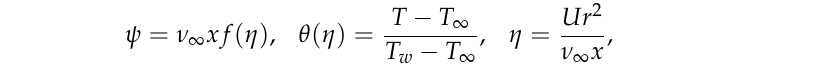
Figure 1. A schematic of the flow model.